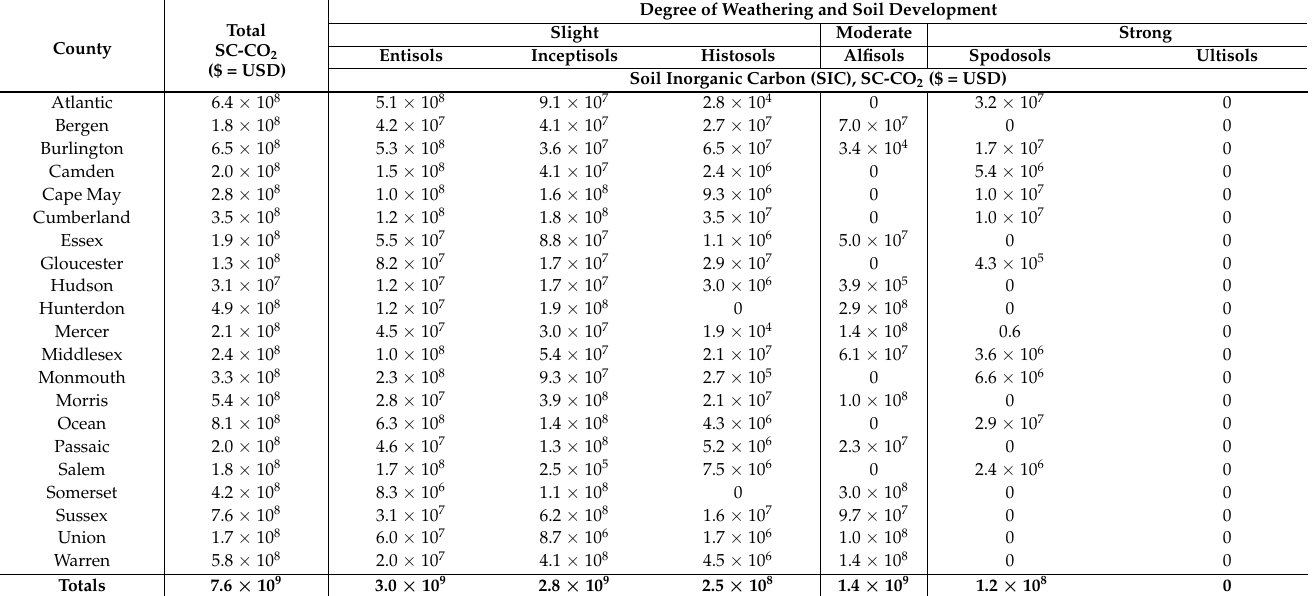
Table 6. Midpoint monetary values of soil inorganic carbon (SIC) by soil order and county for the state of New Jersey (USA), based on the areas shown in Table 3 and the area-normalized midpoint monetary values in Table